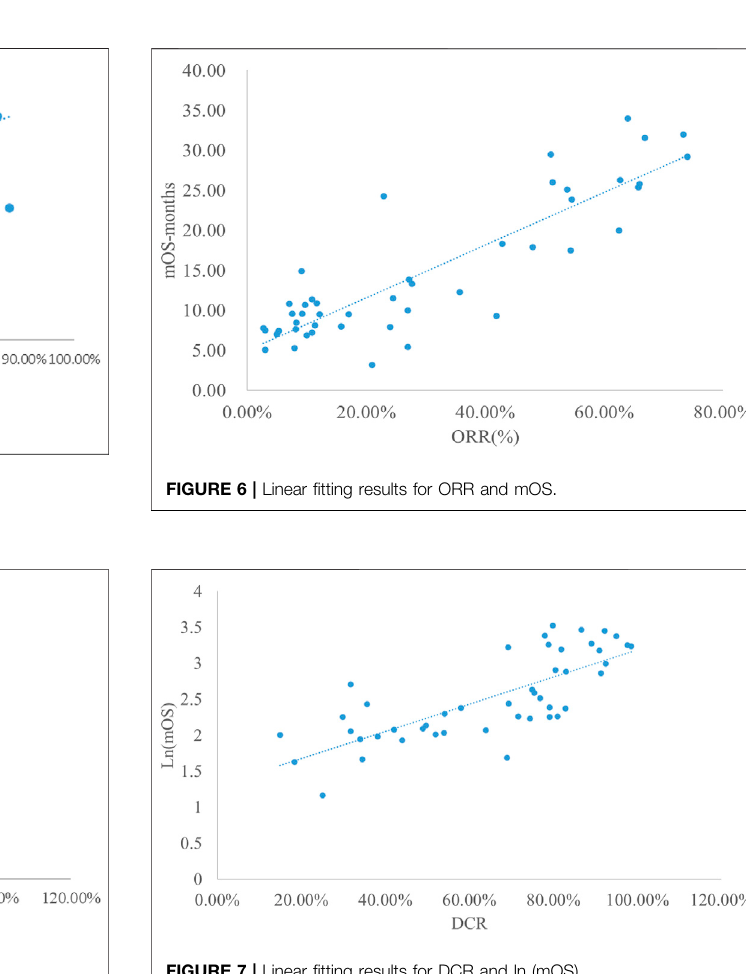
FIGURE 7 | Linear fi tting results for DCR and ln